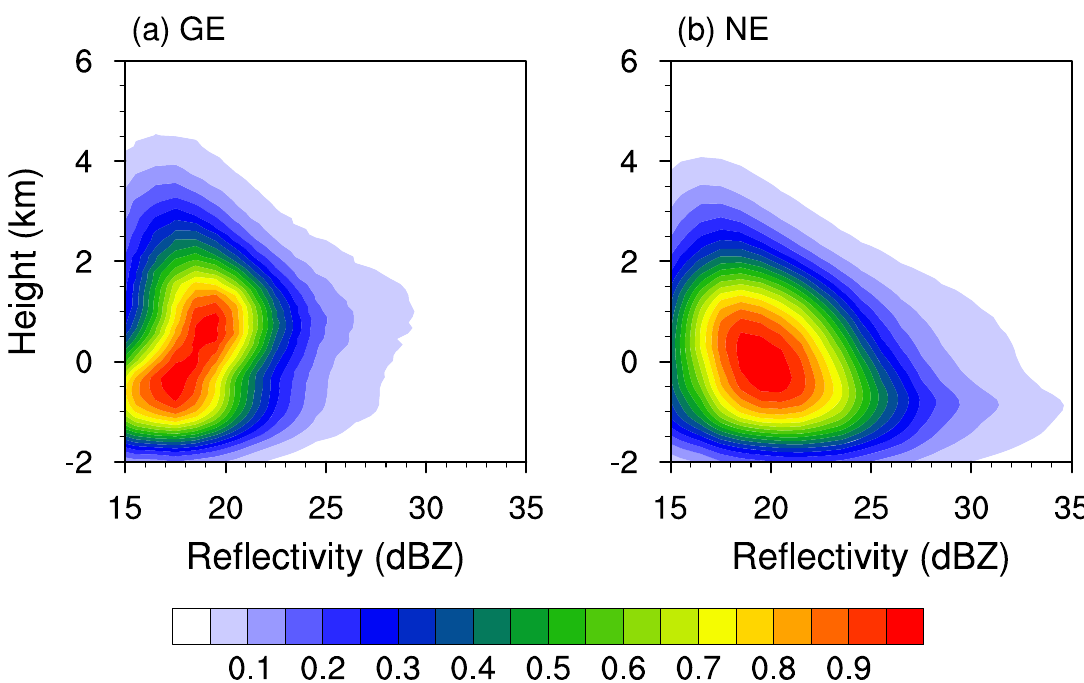
Fig. 2 Contoured frequency by altitude diagrams of re fl ectivity. a Ghost echo (GE). b Normal echo (NE). The coloring represents the joint histograms of radar re fl ectivity and height, which were normalized by the largest bin values. The height is the difference between the actual altitude and the freezing